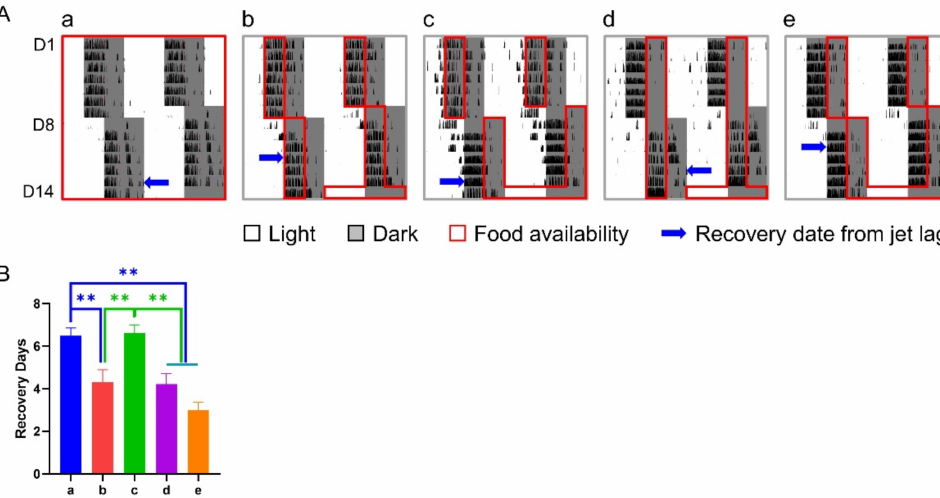
Figure 2. Effect of 6-h TRFs on behavioral adaptation in mice treated with a 6-h delay phase shift. ( A ) Representative double-plotted actograms of wheel running activity of mice in group a–e. Right and left blue arrows indicate the date when the mouse was re-entrained based on the calculation of onset and offset of daily activity, respectively. ( B ) Days for recovery from the shift. ** p < 0.01, one-way ANOVA with Tukey’s multiple comparisons test ( n =